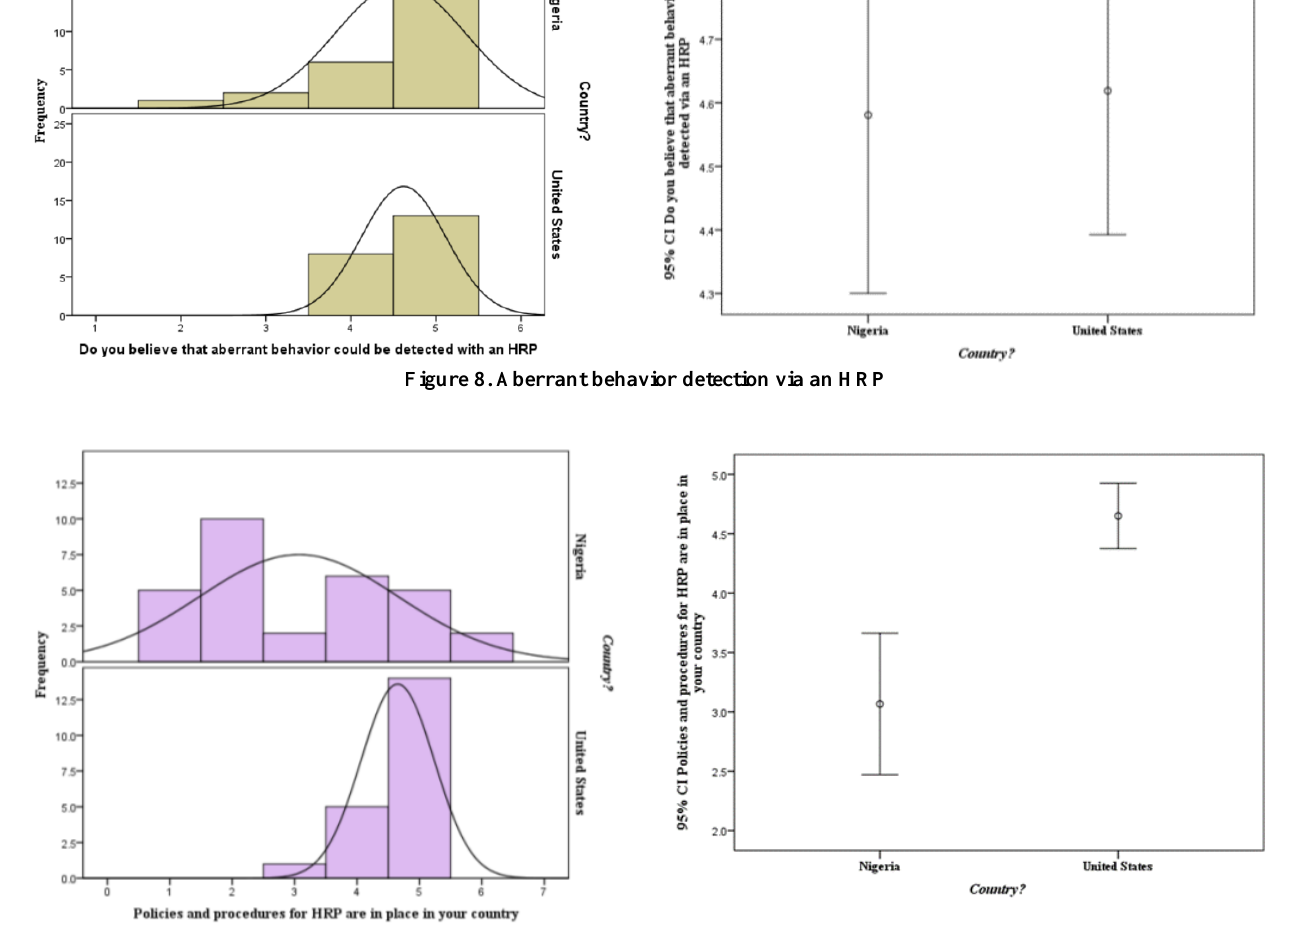
Figure 9. HRP policies and procedures are in place (Nigeria and the United States)